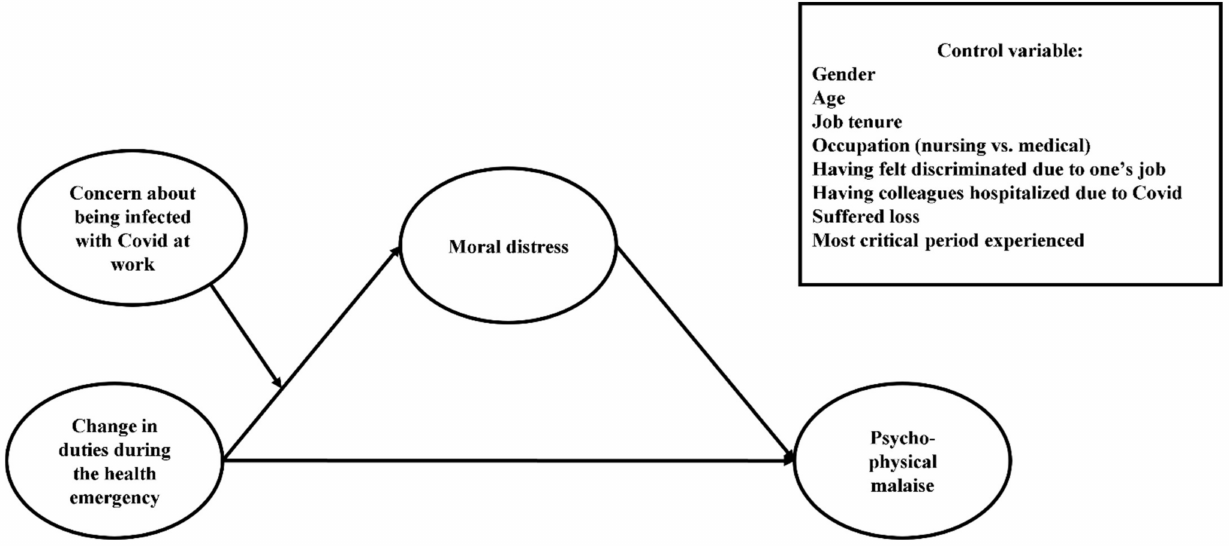
Figure 1. Conceptual